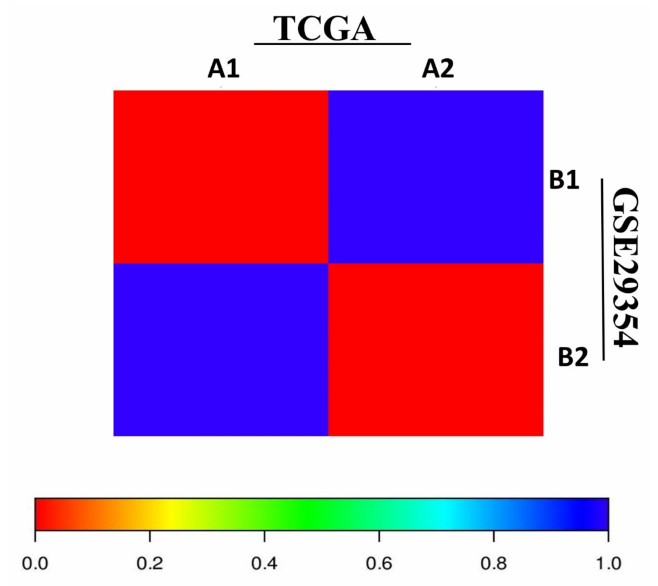
Figure 3. A significant association between the two molecular subtypes of eMPM from the two independent datasets of TCGA and GSE29354. The correlation significance was expressed as an FDR-corrected p